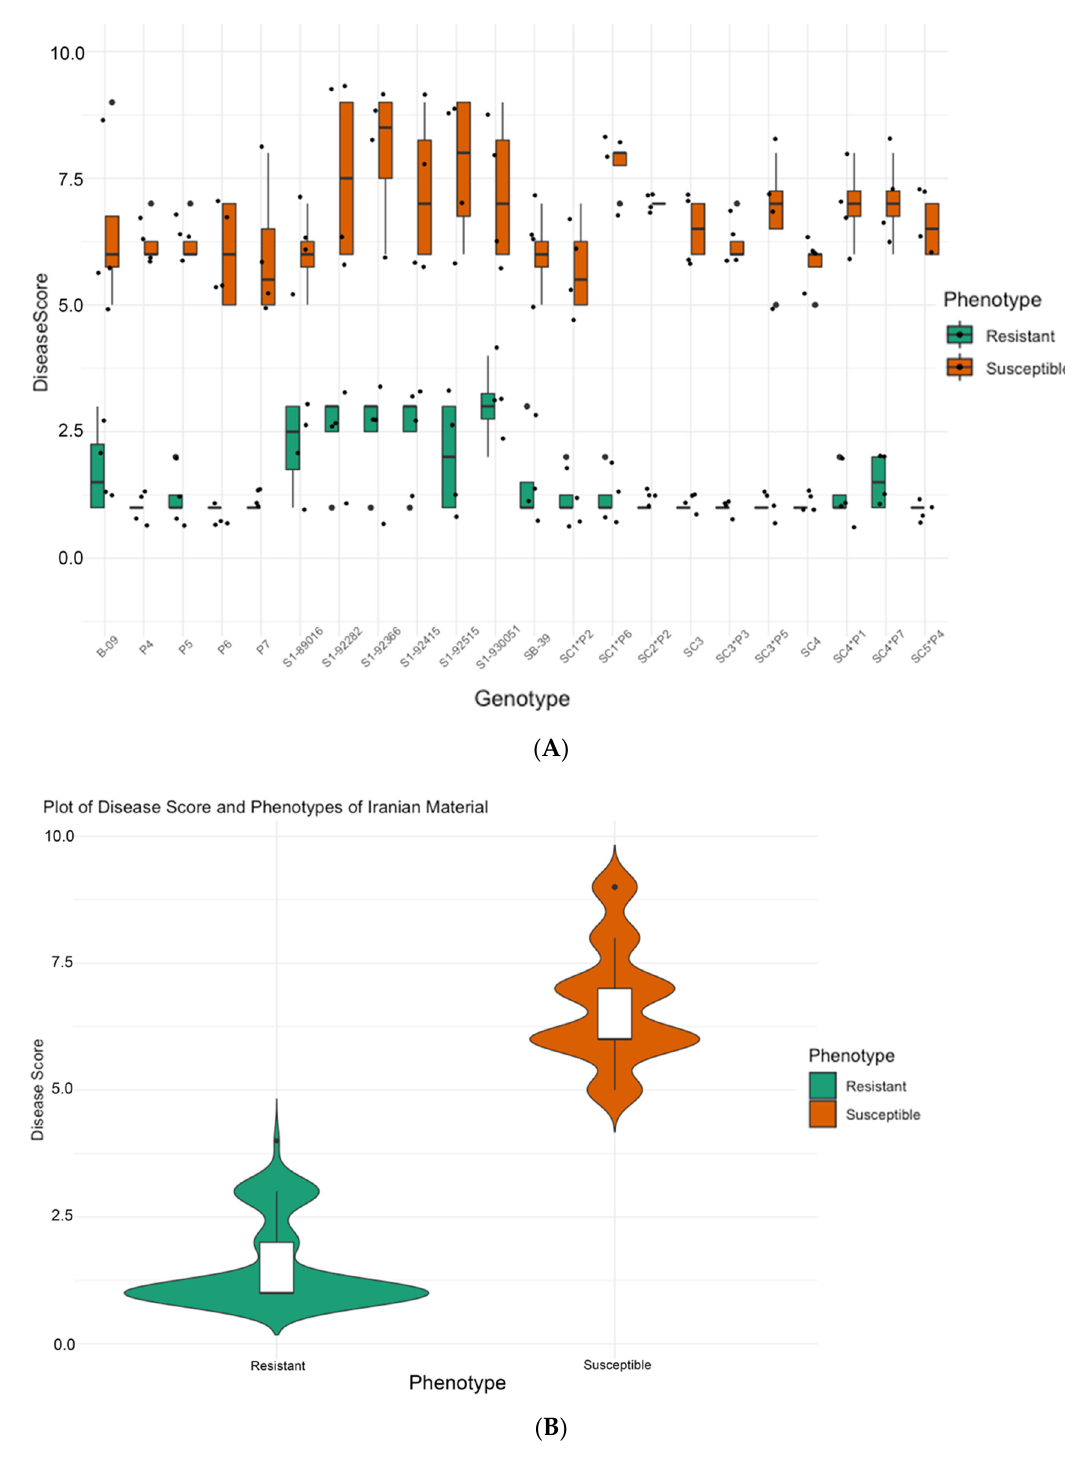
Figure 1. ( A ) Distribution of disease severity [2] scores across tested germplasm from SBSI which shows the range of variation for plants from each variety classified as resistant and susceptible. ( B ) Resistance trait summary plot of material grouped based on phenotype, the width of the shaded area can be correlated with the density of the data points. For the germplasm from Strube, Germany, the distribution of disease scores of two ‐ three randomly chosen plants from 46 parental lines are shown in Figure 2A. The resistant group shows an average of 1.09 ± 1.06 disease severity whereas the susceptible group presented an